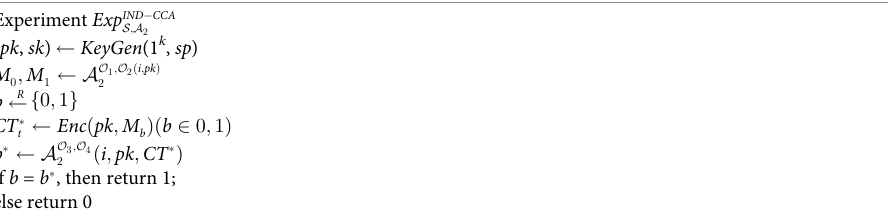
Table 2. The security model of Type-2